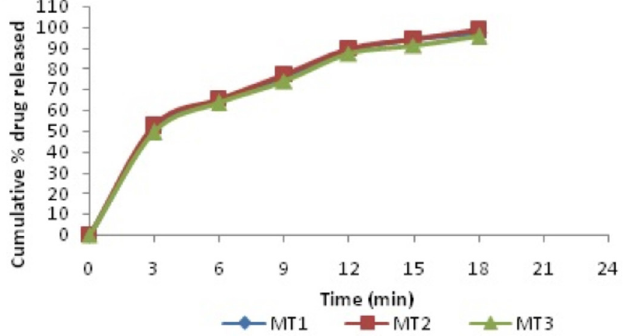
FIGURE 8 - In vitro release of metoprolol tartrate from tablets of MT1 to MT3.